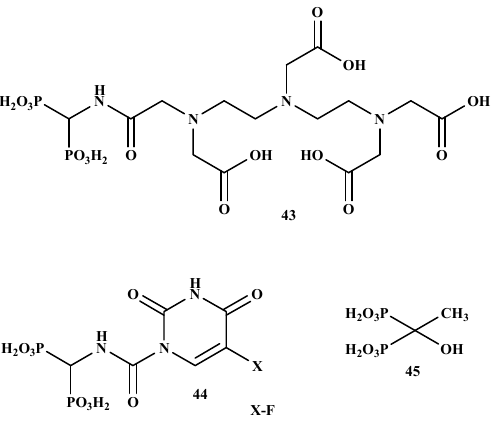
Figure 8. The structures of BP-conjugates 43–45 reported by El-Mabhouh et al. [56]. Tumor-induced bone disease (TIBD) is one of the significant reasons for mortality and morbidity in people with malignant growth. The development of an active drug for the treatment of TIBD is necessary because it causes extensive morbidity [52]. TIBD is common in cancer patients and a median survival of less than two years. The development of BP-conjugates with improved anti-resorptive and cytotoxic is a pressing need to enhance the medication for patients with TIBD. BP-conjugates can be utilized effectively as bone-targeting therapeutics. In addition, BP-conjugates can enhance the control of disease-associated symptoms, reduce the intrusion of remedy on the events of everyday life, and reduce treatment-related toxicity [57]. BP-conjugates, (MBC-1 (46), MBC-11 (47), MBC-9 (48), and MBC-29 (49)) as shown in Figure 9. The results showed that compound 47 can be delivered to the bone and it displayed anti-tumor activity with prolonged survival rate, making it a promising therapy for TIBD [57].